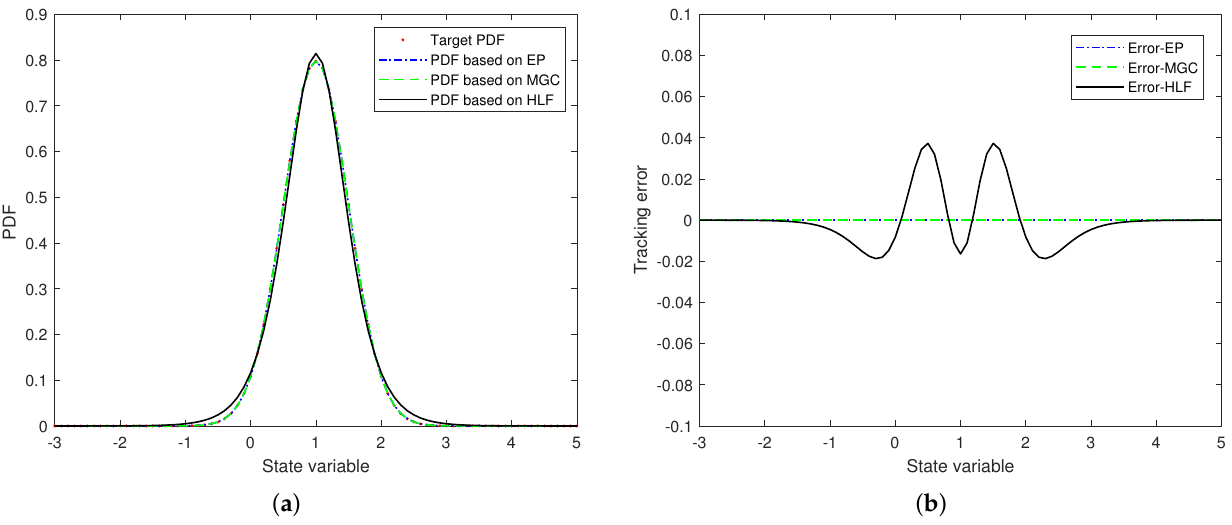
Figure 1. Case 1: unimodal target PDF (Gaussian distribution). ( a ) Control effect. ( b ) Tracking error. (2) Case 2 The target PDF beta probability density function has an asymmetric unimodal